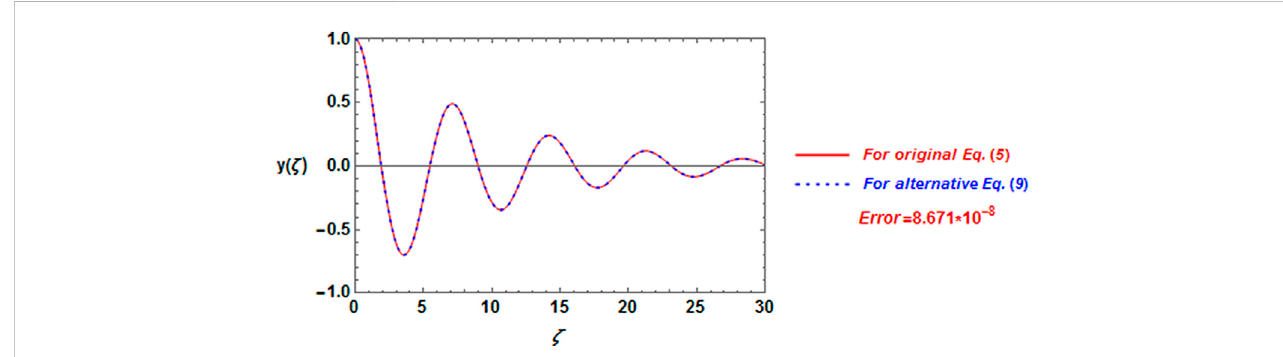
FIGURE 1 Comparison of the numerical solution between Eq. 5 and Eq.